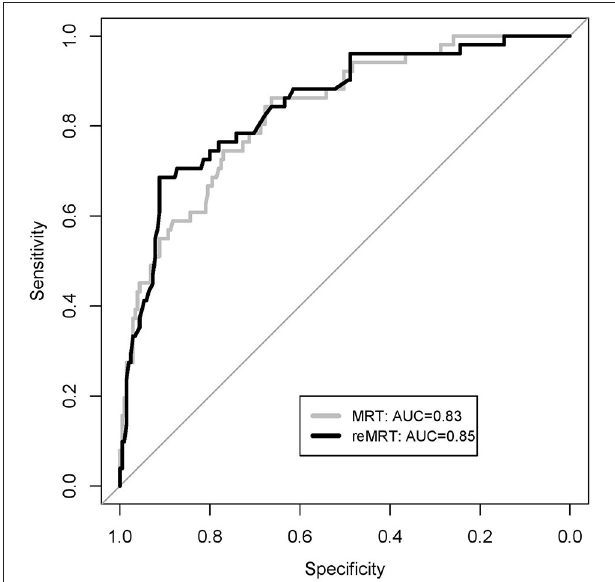
FIGURE 1 | Receiver operating characteristic (ROC) curves of the minimal risk tool (MRT) model and the re-estimated MRT model (reMRT) on the SMARTOOL